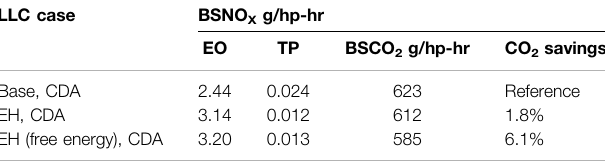
TABLE 3 | LLC emissions with 5 kW EH and CDA.